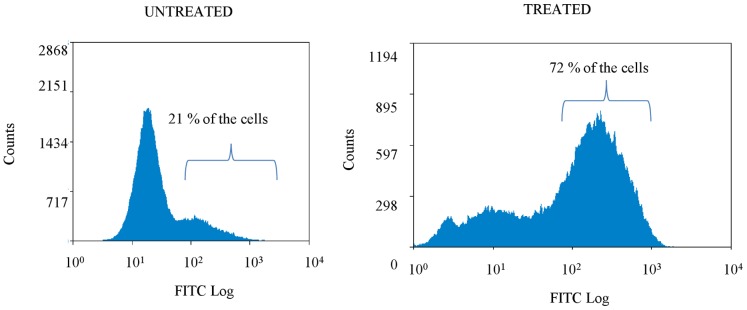
The number of cells in function of the DCHFDA-derived fluorescent signal for untreated and treated biofilms.Treated biofilms were exposed to tobramycin in a concentration of 4×MIC (1024 µg/ml) (24 h). The mean percentage of cells with a high fluorescent signal (>30) is indicated (n = 7). Differences between treated and untreated biofilms are statistically significant (p<0.05).